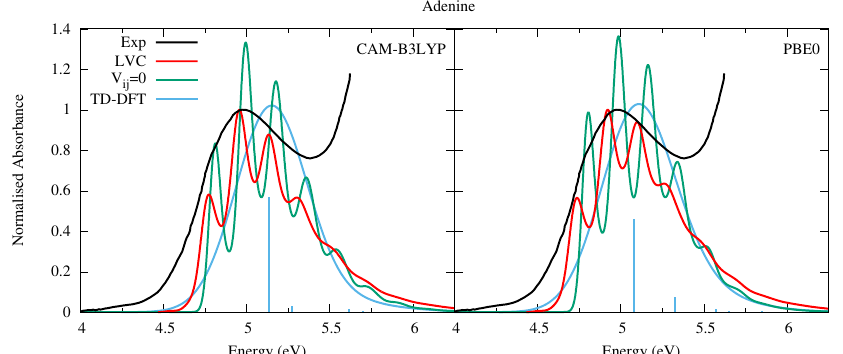
Figure 7. Absorption spectra of Adenine from the LVC model (red), without inter-state coupling (green), TD-DFT calculations with stick spectra (blue), and experimental data (black) [52]. Main peak from experiment and LVC spectra normalised to 1, with other calculated spectra normalised with the same value as LVC spectra. CAM-B3LYP spectra red-shifted by 0.25 eV, PBE0 by 0.08 eV. LVC spectra broadened with Gaussian HWHM 0.04 eV, TD-DFT with HWHM 0.25 eV.